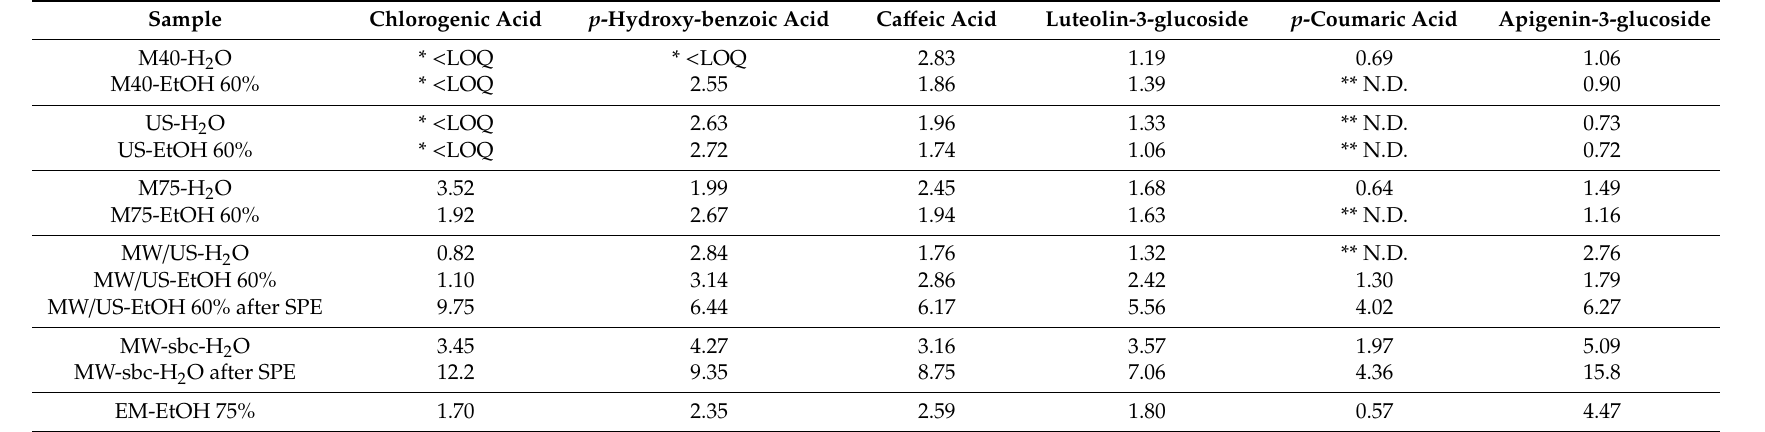
Table 3. Quantification of the identified compounds. Data are expressed as mg / g dried extract